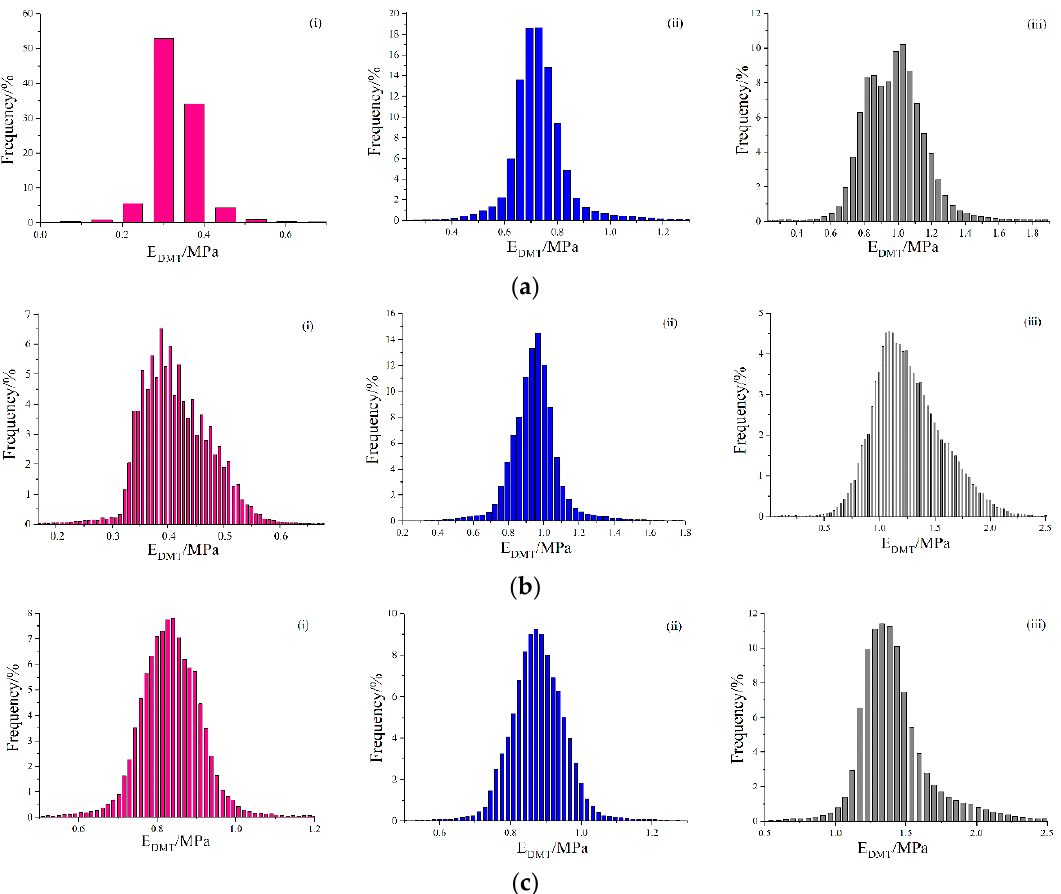
Figure 4. Histograms of the DMT modulus of bitumen before and after lab-simulated aging: ( a ) 70# bitumen; ( b ) 50# bitumen; ( c ) 30# bitumen, for ( i ) Virgin; ( ii ) RTFO; ( iii ) PAV. Table 2. Structural similarity index (SSIM) values between the topographic image and the DMT modulus image of different bitumen before and after